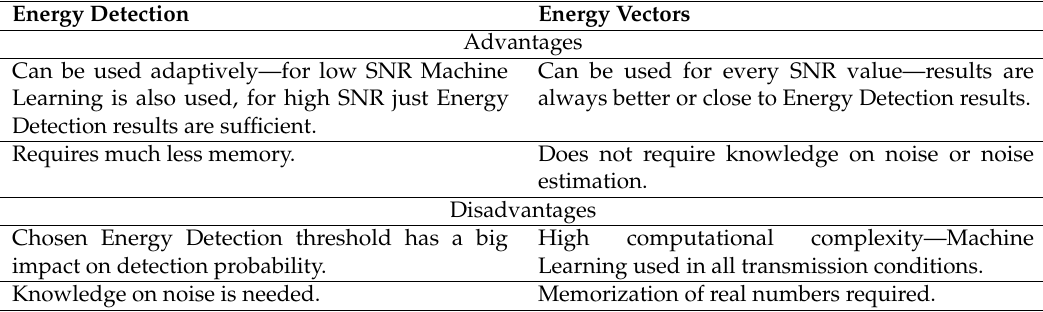
Table 1. Comparison of Energy Detection-based Machine Learning and Energy Vector-based Machine